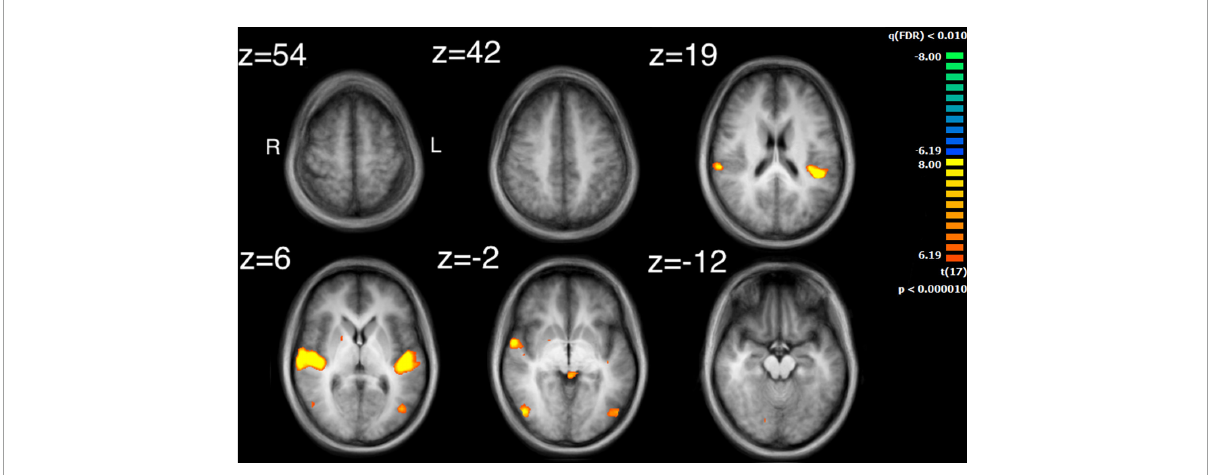
FIGURE4 Activation for the median values of loudness. Significant regions of activity include the bilateral superior temporal gyrus, the right inferior temporal gyrus and left middle occipital gyrus.